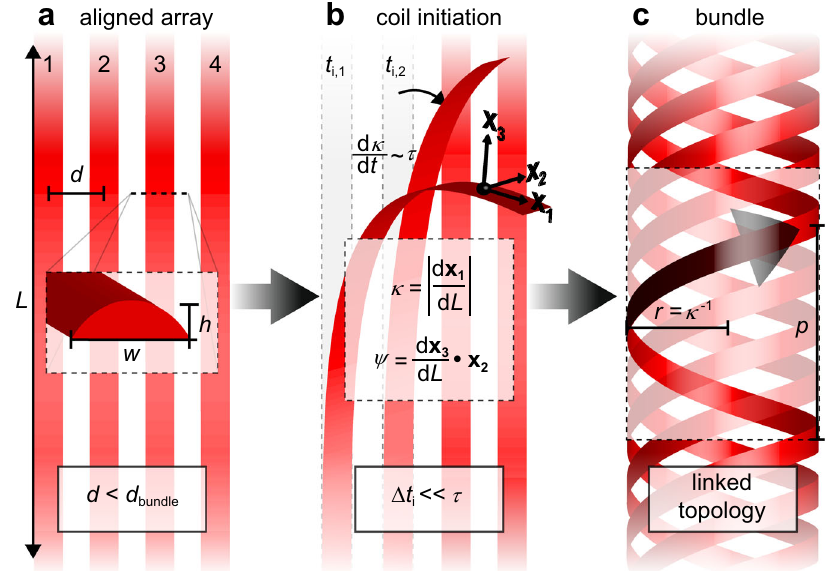
Fig. 1 | Key parameters in twisted bundle formation. a Aligned ribbons of thickness h , width w , and arc length L with periodic spacing d ; b coil initiation of ribbons1and 2attimes t i,n . The timescale τ de fi nescoiling rate afterinitiationwith